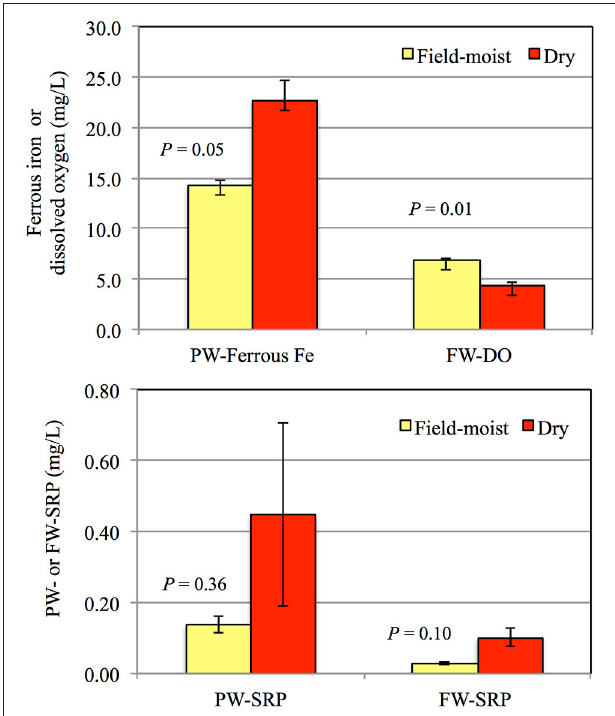
FIGURE 3 | Average porewater ferrous Fe (PW-Fe 2 + ), floodwater dissolved oxygen (FW-DO), porewater soluble reactive phosphorus (PW-SRP), and floodwater soluble reactive phosphorus concentrations (FW-SRP) for field-moist soil versus flooding after drying. Results were averaged for sites 2 and 5. Error bars represent the standard error of the mean (SD/2 0.5 ) and P -values were calculated based on a student’s t